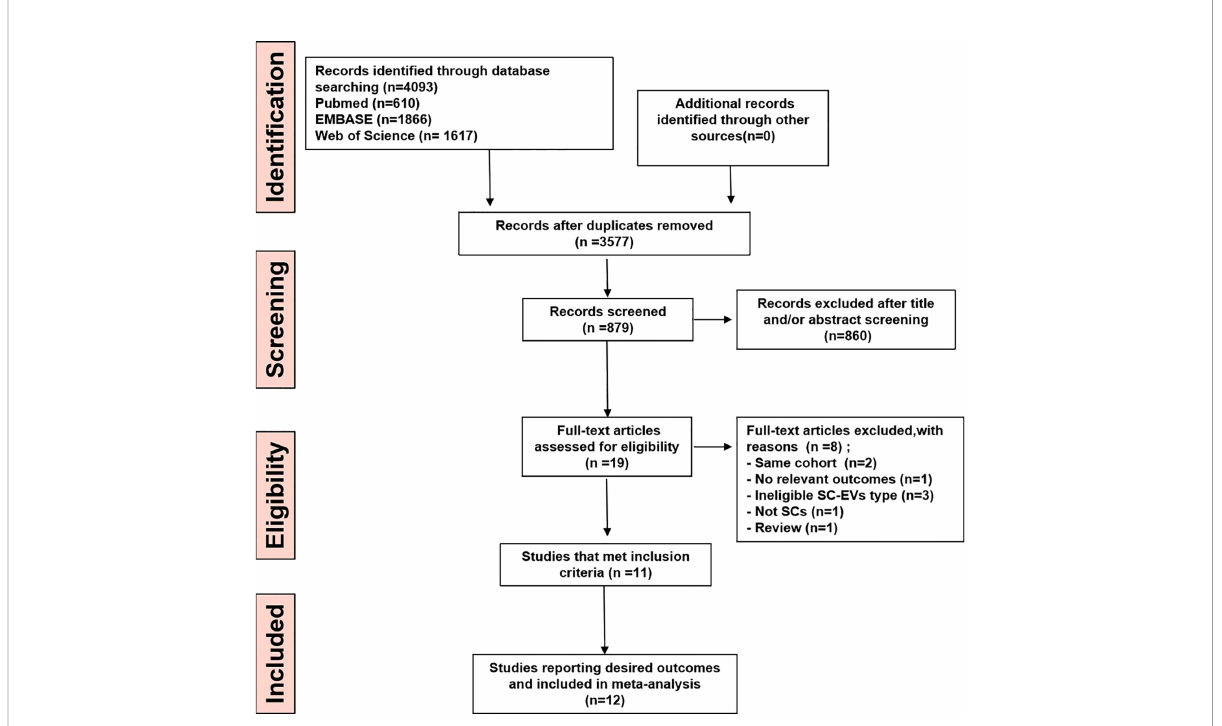
FIGURE 1 PRISM A fl ow diagram for review and selection process of studies included in meta-analysis of MSC-EVs in rodent models of